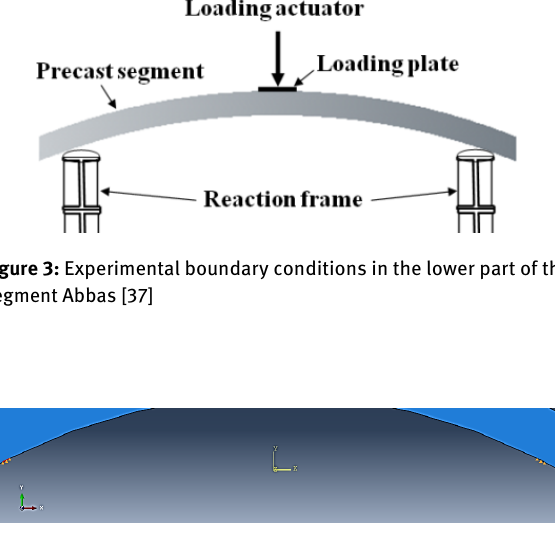
Figure 6: Load-displacement curve of the model with two mesh